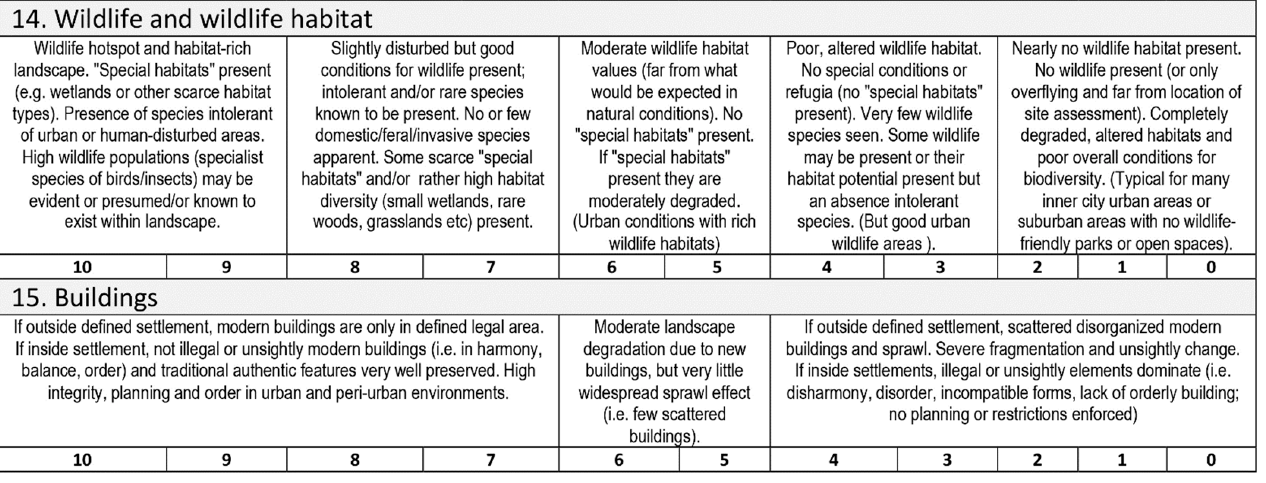
Figure A1. The LAP scoring guidance sheet. Showing the guiding narrative and relevant score gradient (10 = reference conditions, i.e. “excellent” condition; 0 = poorest degraded quality, “bad” condition). This guidance sheet is used alongside the LAP field form’s scoring card (Figure 1) to guide scoring of landscape views on site. Table A1. Site dataset with location information (coordinates in WGS84—Decimal Degrees